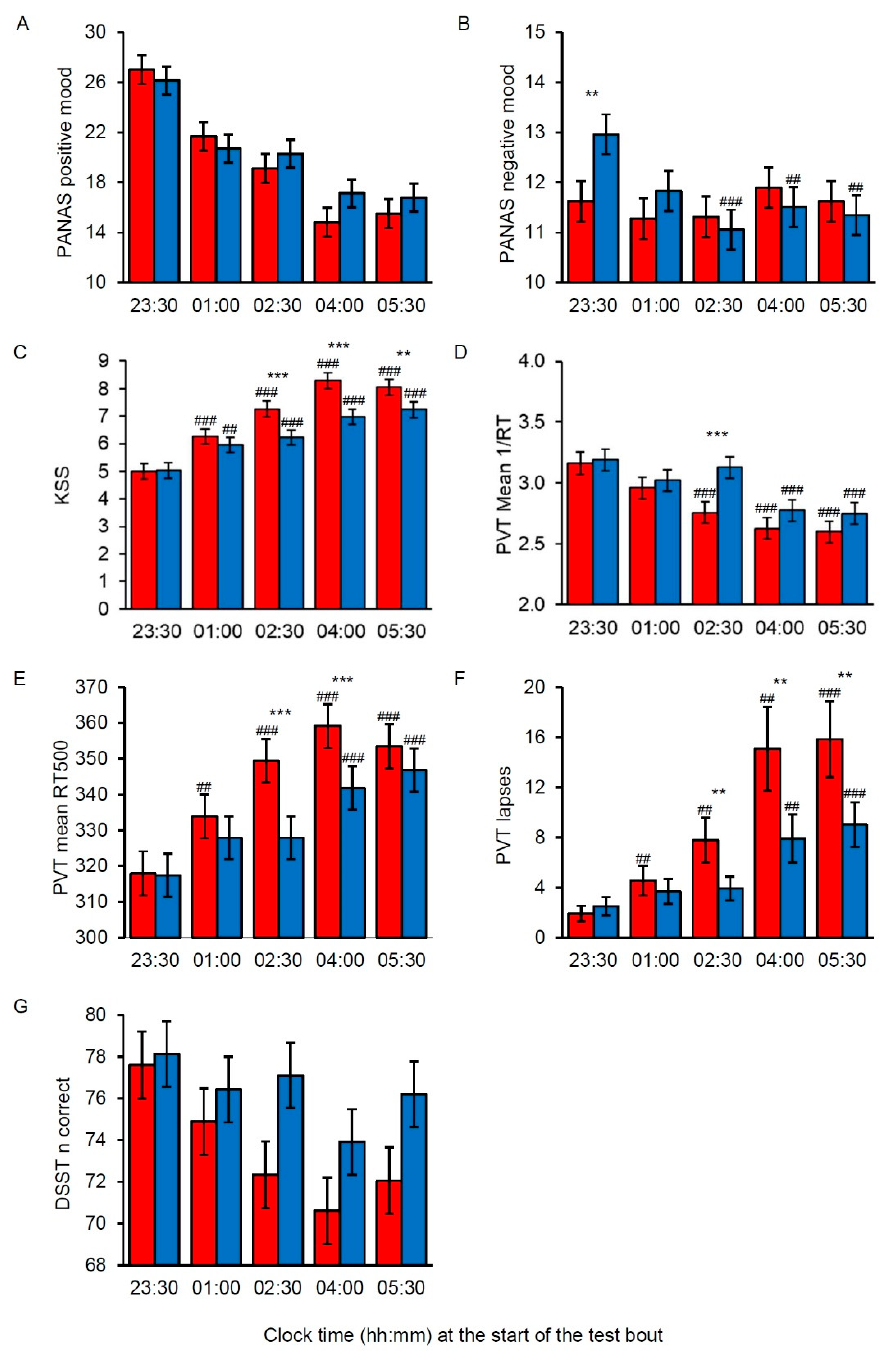
Figure 3. Mood, sleepiness and performance during a simulated night shift in long-wavelength narrow-bandwidth light (red bars) and short-wavelength narrow-bandwidth light (blue bars). The bars represent estimated marginal means with error bars indicating standard error. ( A ) Positive mood assessed with the Positive and Negative A ff ect Schedule (PANAS). ( B ) Negative mood assessed with PANAS. ( C ) Subjective sleepiness assessed with the Karolinska Sleepiness Scale (KSS). ( D ) Reciprocal response times (mean 1 / RT) on the Psychomotor Vigilance Task (PVT). ( E ) RTs excluding lapses (mean RT500) on the PVT. ( F ) Number of lapses (RTs ≥ 500 ms) on the PVT. ( G ) Number of correct responses on the Digit Symbol Substitution Test (DSST). Significant di ff erences indicated for variables with a significant Light by Time interaction only. Number symbols (#) indicate significant di ff erence compared to the first test bout (23:30 h), and asterix symbols (*) indicate significant di ff erence between light conditions. ##; ** = p < 0.01, ###; *** = p < 0.001.